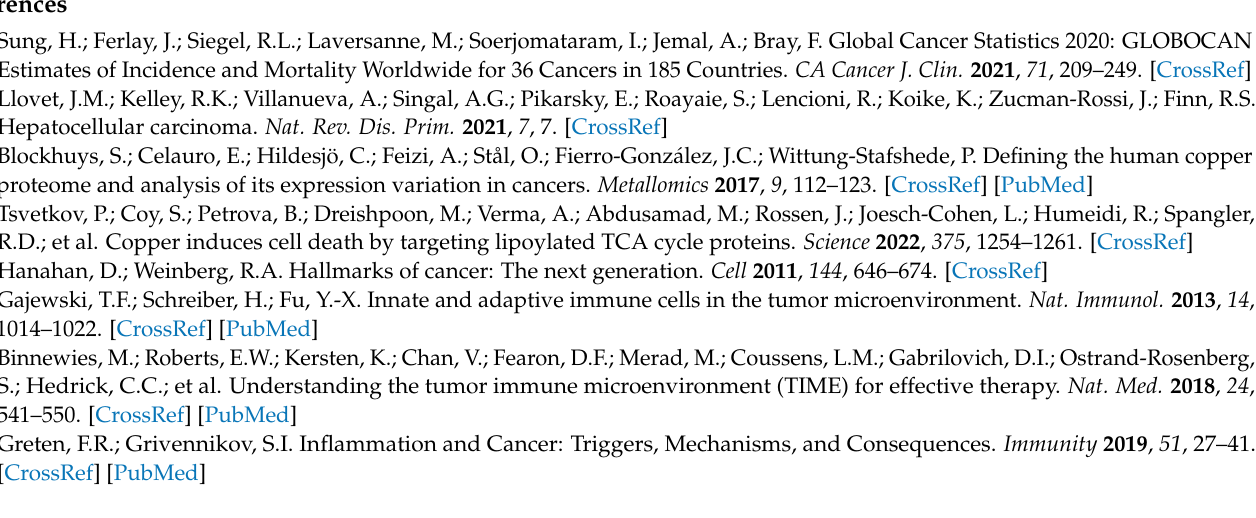
Figure S2: The relationship between clinicopathological characteristics and four genes in TCGA cohort. CDKN2A (A–F), GLS (G–L), LITP1 (M–R), DLAT (S–X); Figure S3: Four-gene signature model predicts recurrence-free survival in TCGA cohort (A) and in-house cohort data. Time-dependent ROC curves (B) and (D) of risk score prognostic performance; Figure S4: (A) UMAP plot showing immune cell distribution from 6 samples based on scRNA-seq. (B) UMAP plot showing the distribution of the six cell types of each sample for 6